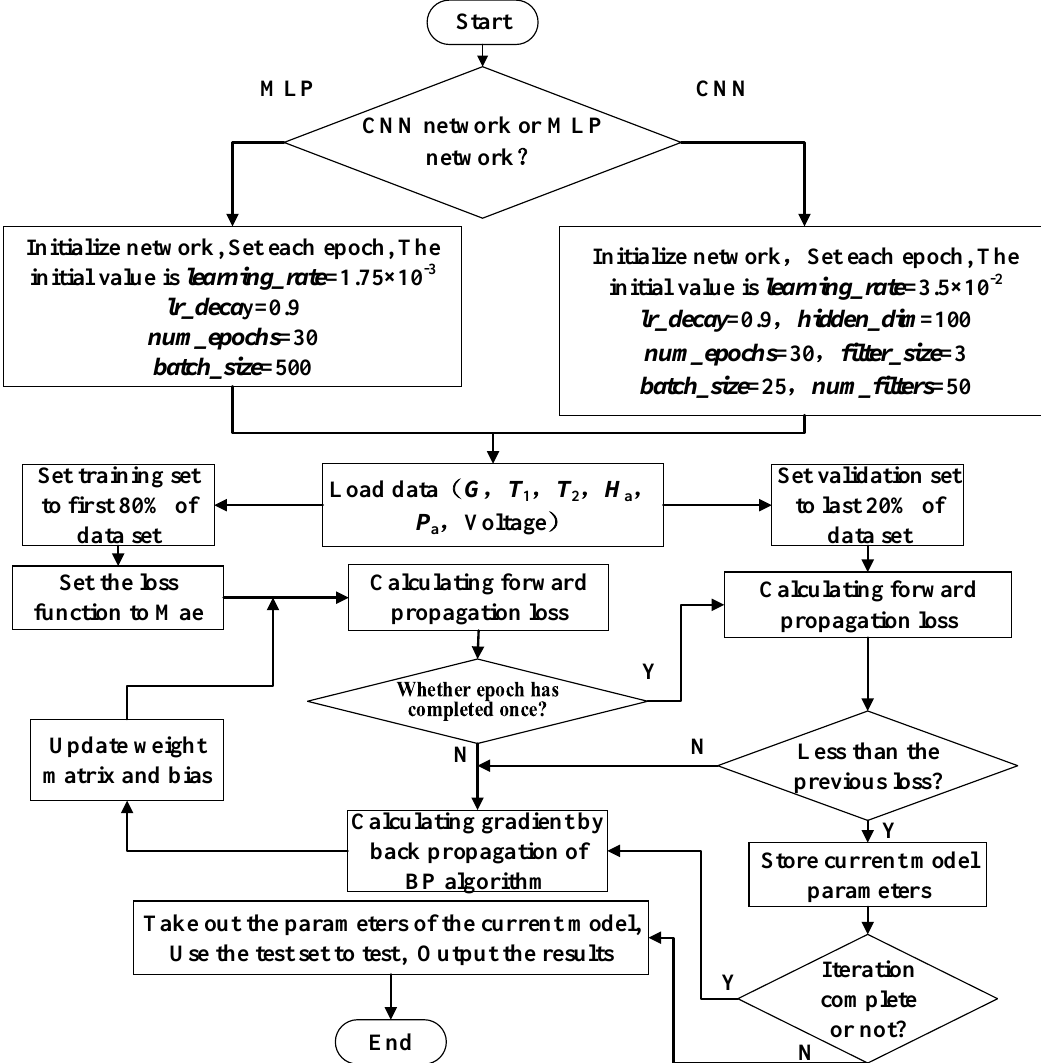
Figure 3. Program flow chart of multilayer perceptron (MLP) and convolutional neural network (CNN).